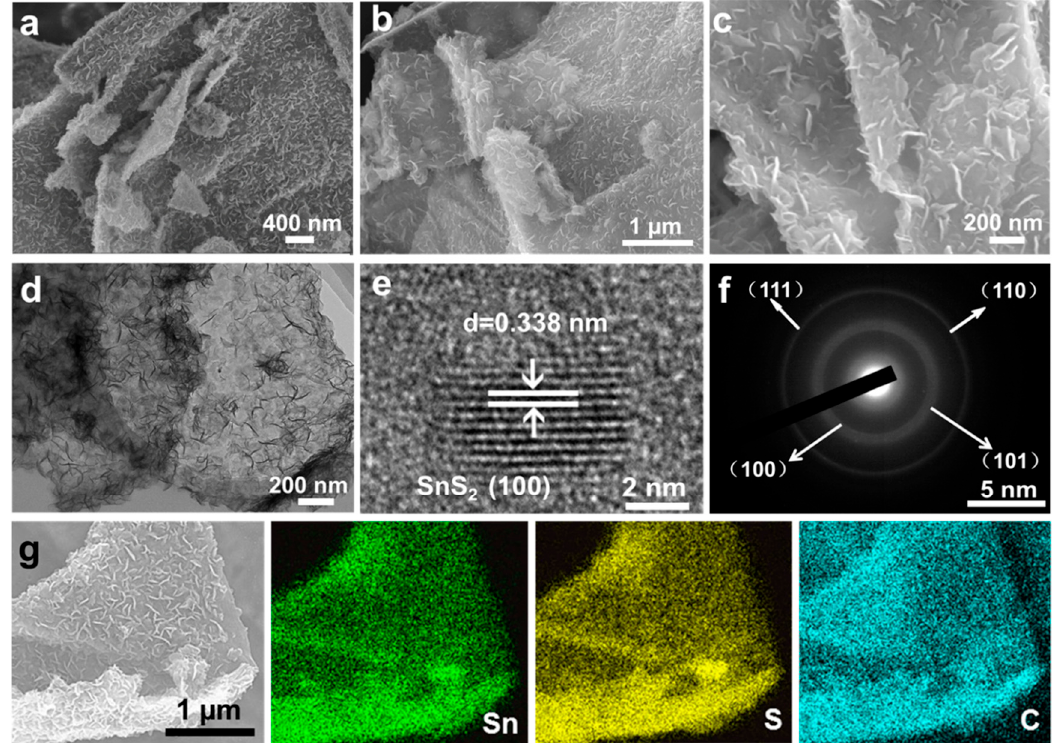
Figure 2. ( a ) FESEM image of Sn/RGO-based precursor. ( b , c ) FESEM images of SnS 2 /RGO at different magnifications. ( d ) TEM image of SnS 2 /RGO. ( e ) HRTEM image of SnS 2 /RGO. ( f ) Corresponding SAED pattern. ( g ) A typical FESEM image of SnS 2 /RGO and the corresponding elemental mappings of Sn, S and C elements (as labeled).